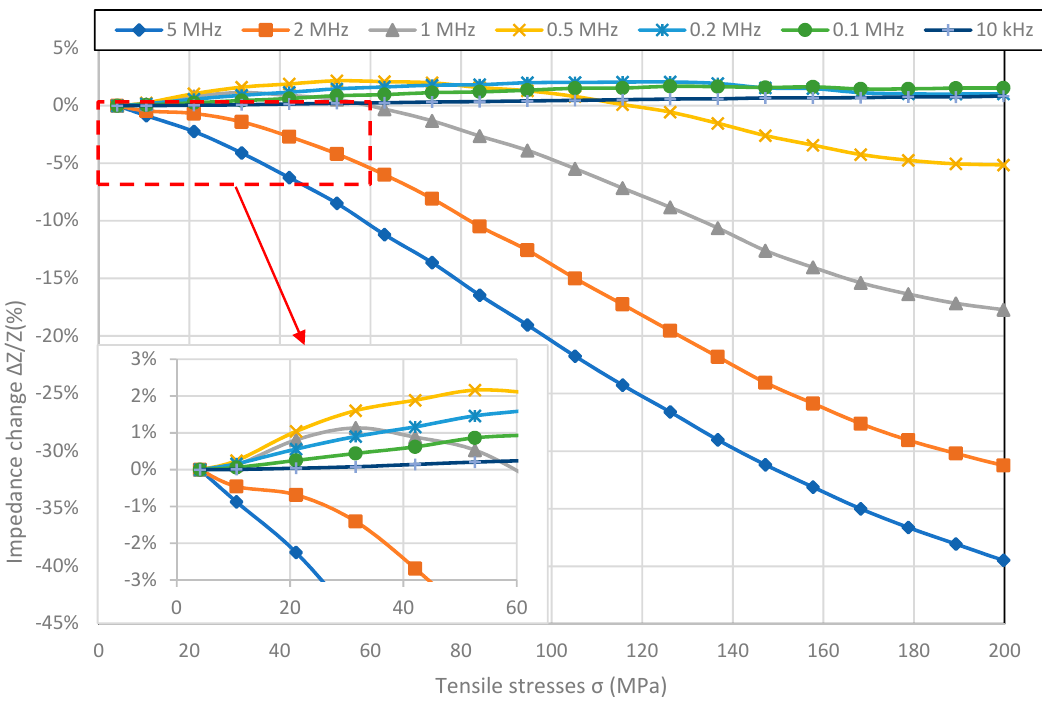
Figure 3. Dependence of sample Fe 40 Ni 38 Mo 4 B 18 impedance on tensile stress σ .